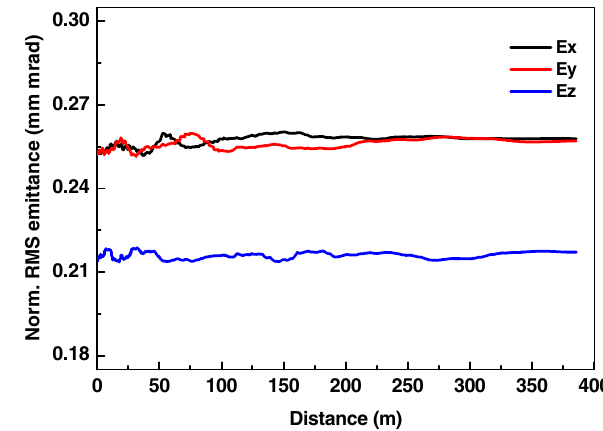
FIG. 19. Phase advances per meter (upper) and phase advances per cell (lower) along the main linac.